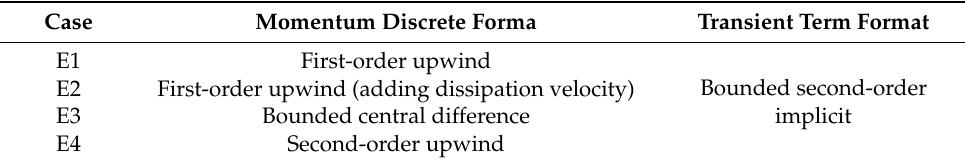
Table 5. Case details of FLUENT with different solution methods.